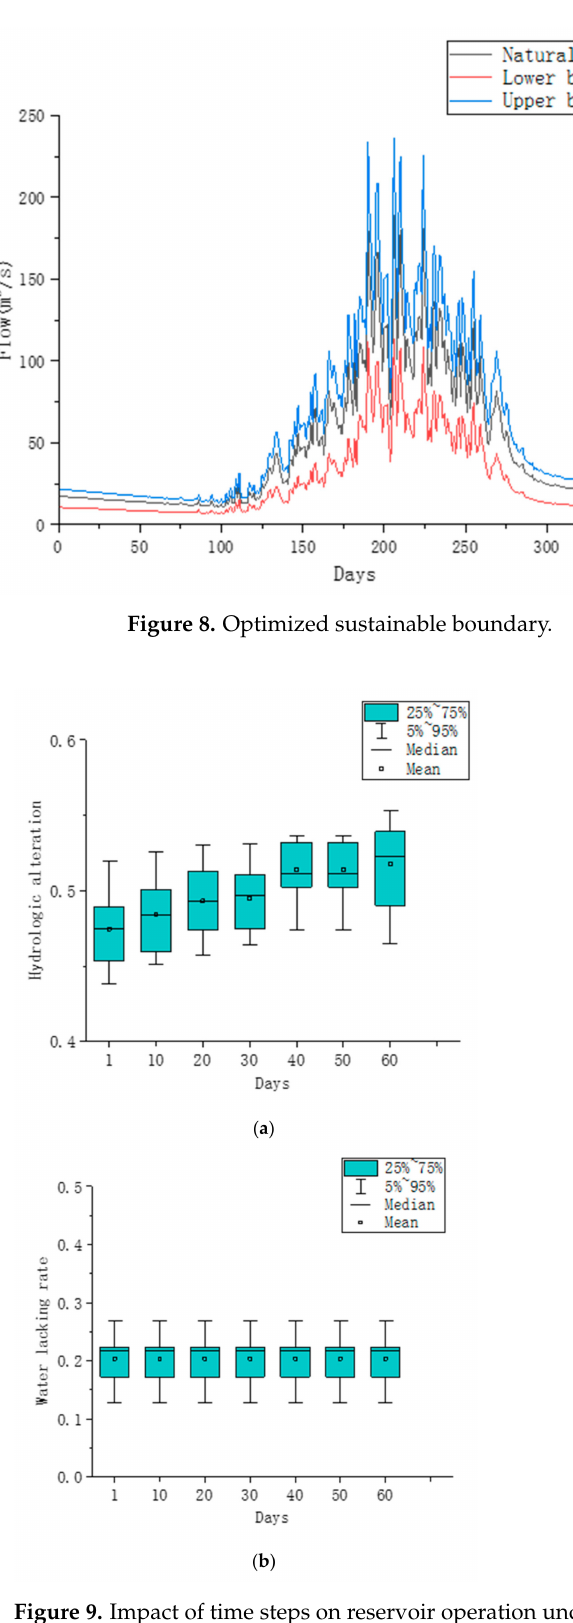
Figure 9. Impact of time steps on reservoir operation under sustainable boundaries. ( a ) Hydrologic alteration in different time steps ( b ) Water lacking rate in different time